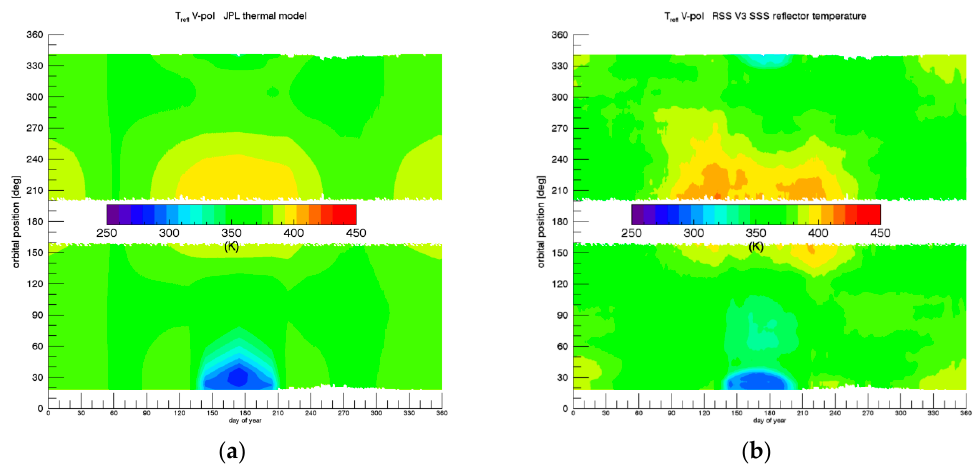
Figure 16 . Physical temperature of the reflector. ( a ) JPL thermal model that is used in the SMAP L1B files [34]. ( b ) Empirical adjustment in the RSS SMAP Version 3 salinity release.